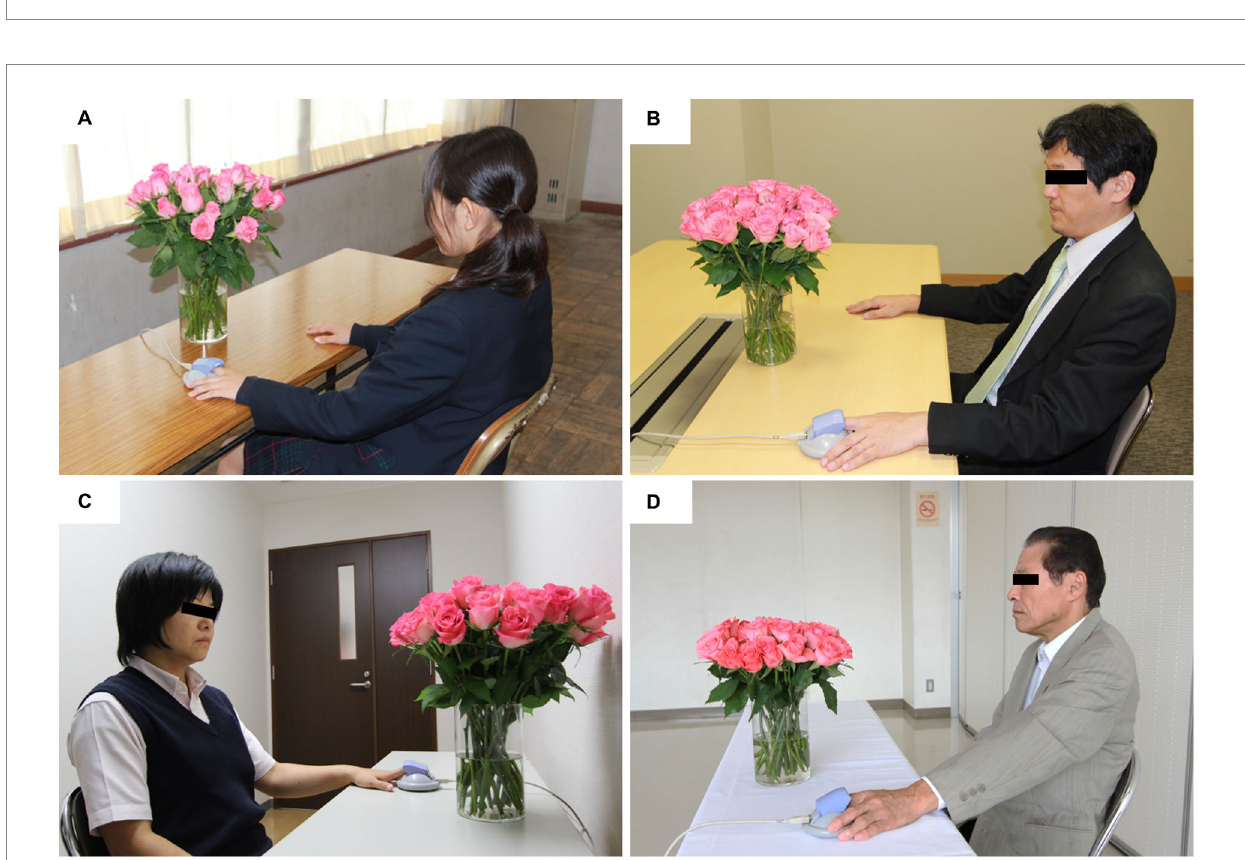
FIGURE 3 Measurement scene in the visual stimulation experiment of fresh rose flowers. (A) High school students, (B) office workers, (C) healthcare workers, (D) elderly